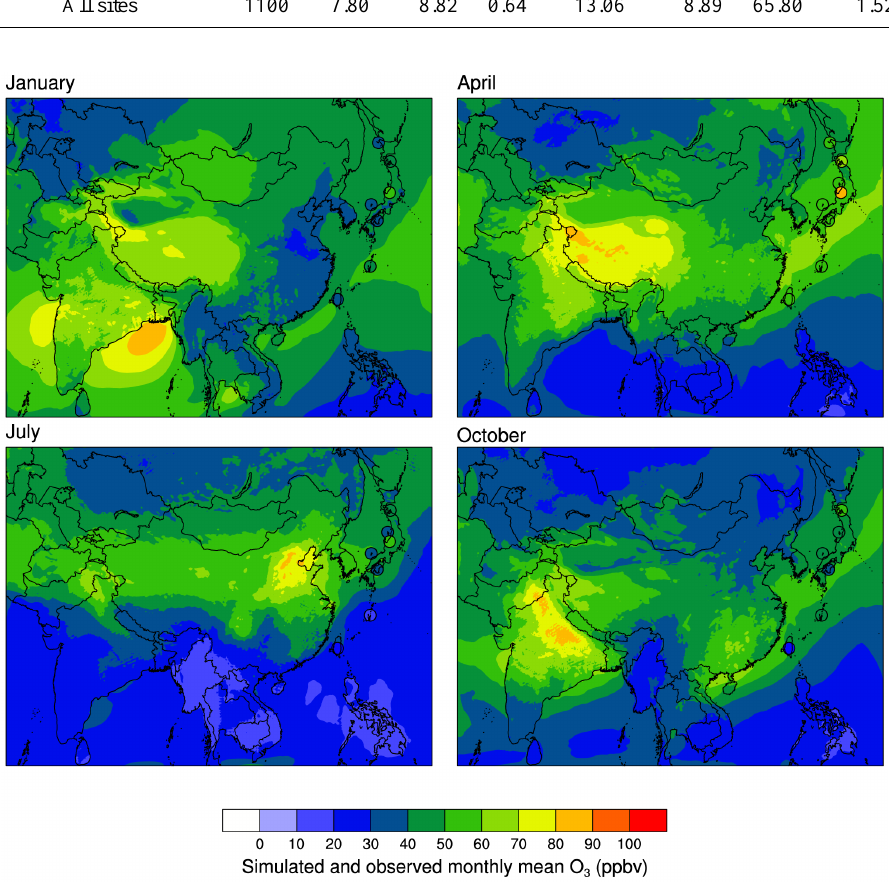
Figure 7. Simulated and observed monthly average surface O 3 in 2007 using WRF-Chem–REAS. The filled circles indicate the observed monthly average